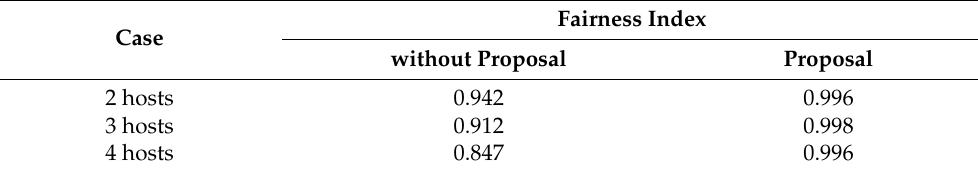
Figure 12. Results for Equal Throughput Scenario with proposal. Table 7. Fairness index comparison for equal throughput